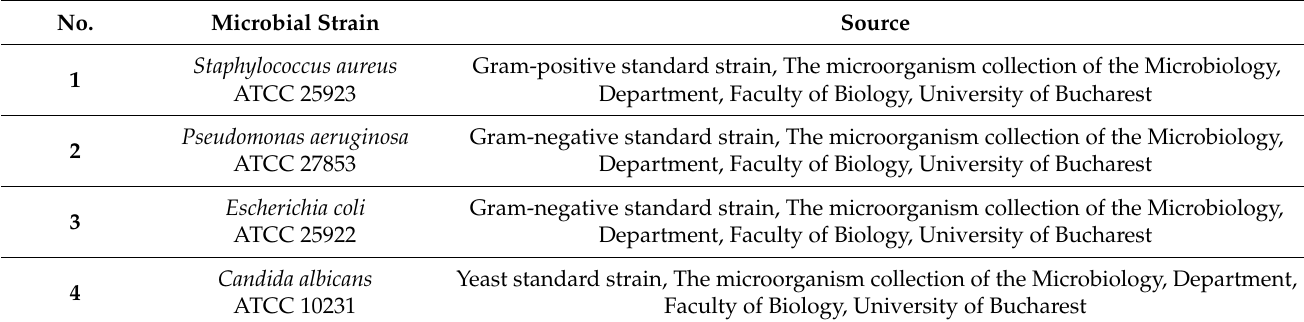
Table 2. Standard microbial strains used for testing antimicrobial